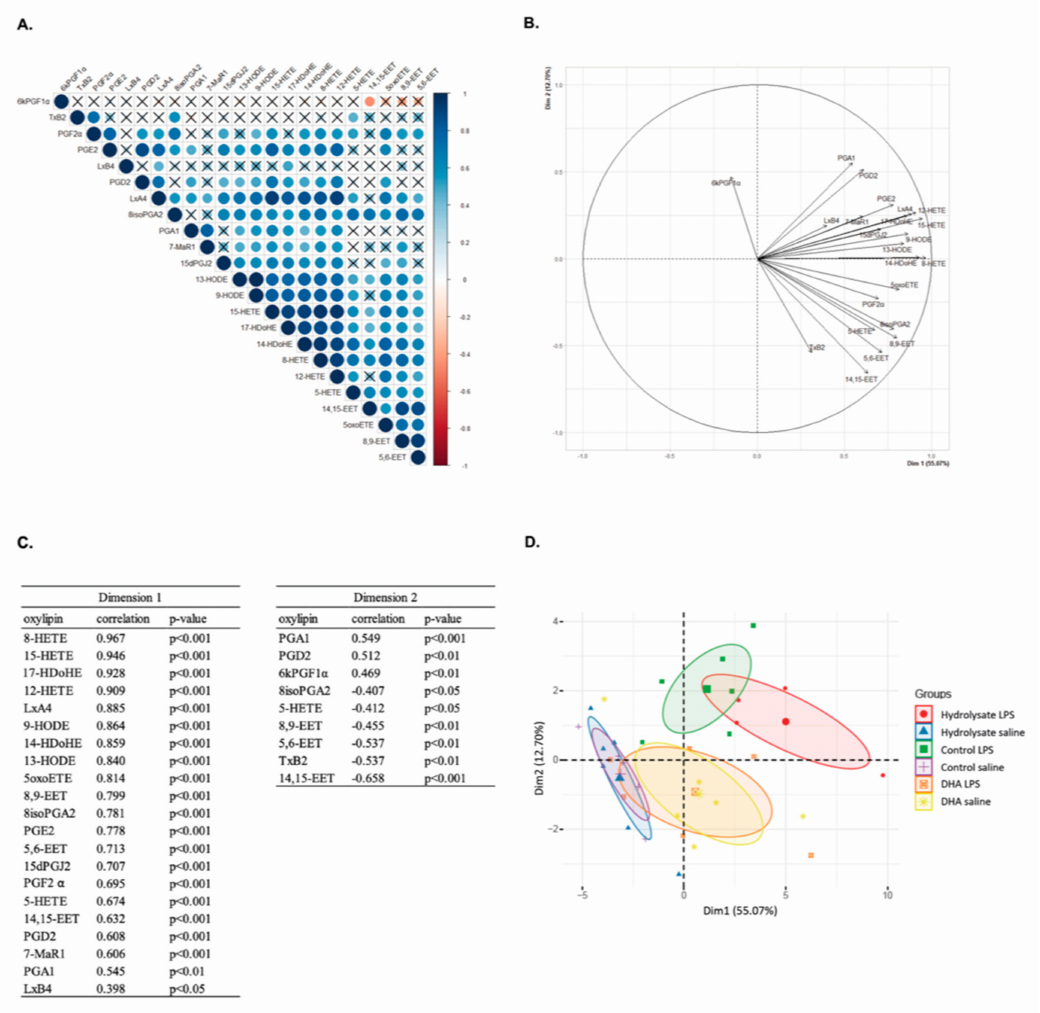
Figure 6. Multivariate analysis of oxylipins in the hippocampus of mice fed orally with control solution, fish hydrolysate or DHA by daily gavage for 18 days, 2 h following LPS injection (125 µ g/kg) . ( A ) Correlation matrix of the 23 oxylipins (blue: positive correlation, red: negative correlation, X: no significant correlation). ( B ) Correlation circle from PCA. ( C ) Correlation between each variable and the principal component score from PCA (dimension 1 or dimension 2). ( D ) Individual map of PCA. 5-oxoETE: 5-oxo-eicosatetraenoic; 7-MaR1: 7(S)-maresin; EET: epoxy-eicosatrienoic acid; HDoHE: hydroxy-docosahexaenoic acid; HETE: hydroxy-eicosatetraenoic acid; HODE: hydroxy-octadecadienoic acid; Lx: lipoxin; PCA: principal component analysis; PG: prostaglandin; TxB2: thromboxane